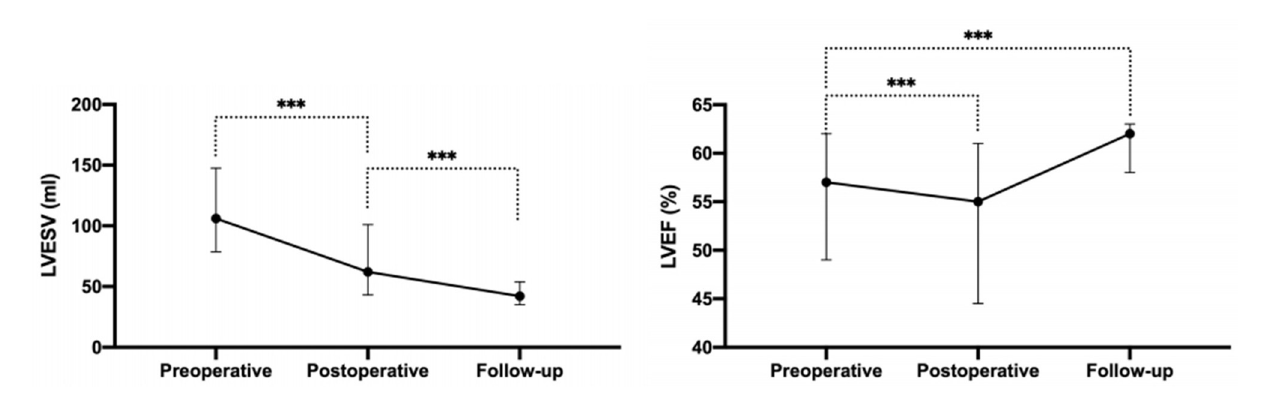
FIGURE2 The LVESV and LVEF before operation, after operation, and during the follow-up. LVESV, left ventricular end-systolic volume; LVEF, left ventricular ejection fraction. *** P < 0.001.